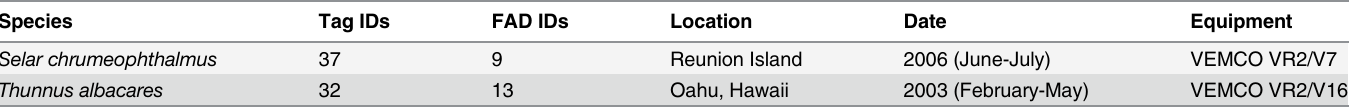
Table 2. Experimental data. Columns from left to right: species, number of tagged individuals, number of instrumented FADs, location and acoustic teleme- try equipment (receiver and tag type) for the two datasets used in this study.